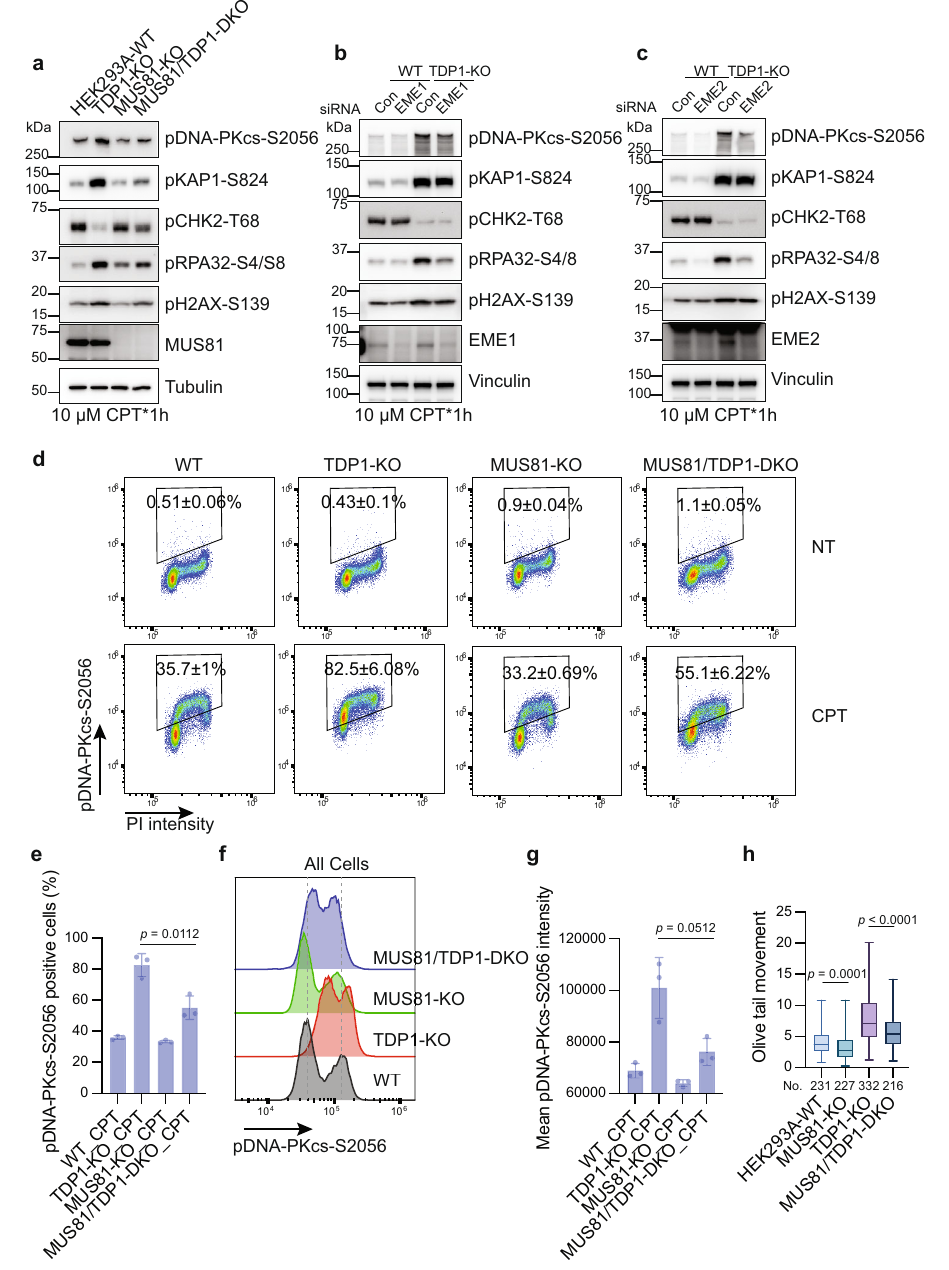
Fig. 7 MUS81 is required for conversion of accumulated TOP1cc into excess DSBs after CPT treatment. a HEK293A-WT, TDP1-KO, MUS81-KO, and MUS81/TDP1-DKO cells were treated with 10 µ M CPT for 1 h. Whole-cell extracts were prepared and subjected to Western blotting with the indicated antibodies. Experiments were repeated at least three times, and similar results were obtained. b , c Control siRNA or siRNA against EME1 ( b ) or EME2 ( c ) were transfected into WT or TDP1-KO cells. 72 h after siRNA transfection, cells were treated with 10 µ M CPT for 1 h. Whole-cell extracts were